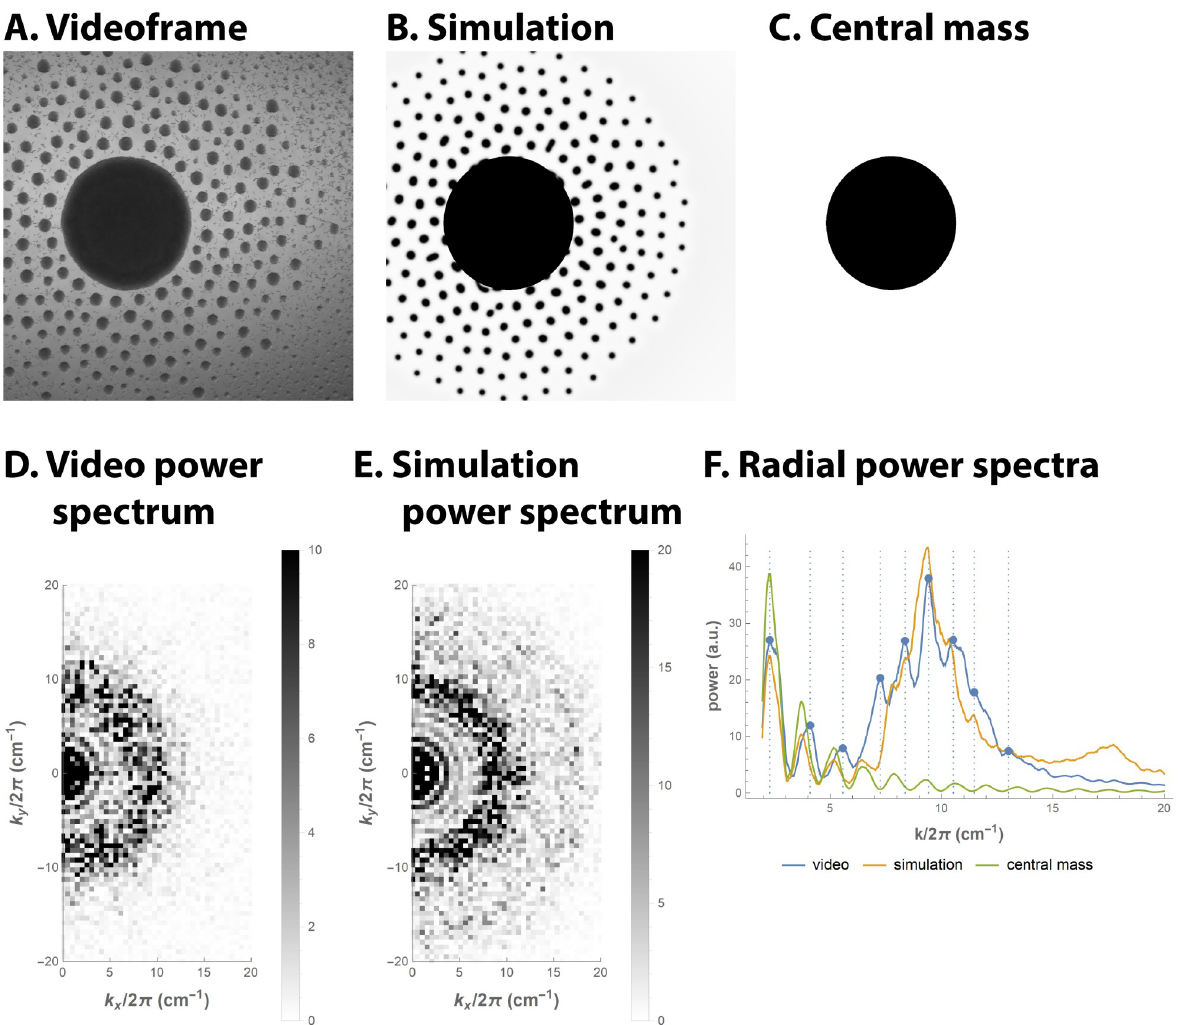
Fig 7. Spectral comparison of experimental and simulation results. A . Last frame of aggregation video S1 Video, cropped to a square to facilitate Fourier analysis. This square is 1.93 cm in size. B . Final time point of the full-scale simulation Fig 6, cropped and scaled to match A as closely as possible, with a corresponding central mass added. C . The central mass alone. D . Low-frequency region of the two-dimensional power spectrum of the discrete Fourier transform of image A . The power scale is truncated at 10 AU (arbitrary units) E . Low-frequency region of the power spectrum of image B . The power scale is truncated at 20 AU. F . Radially summed power spectra of images A , B , and C . Peaks of the experimental image spectrum are picked out in blue.